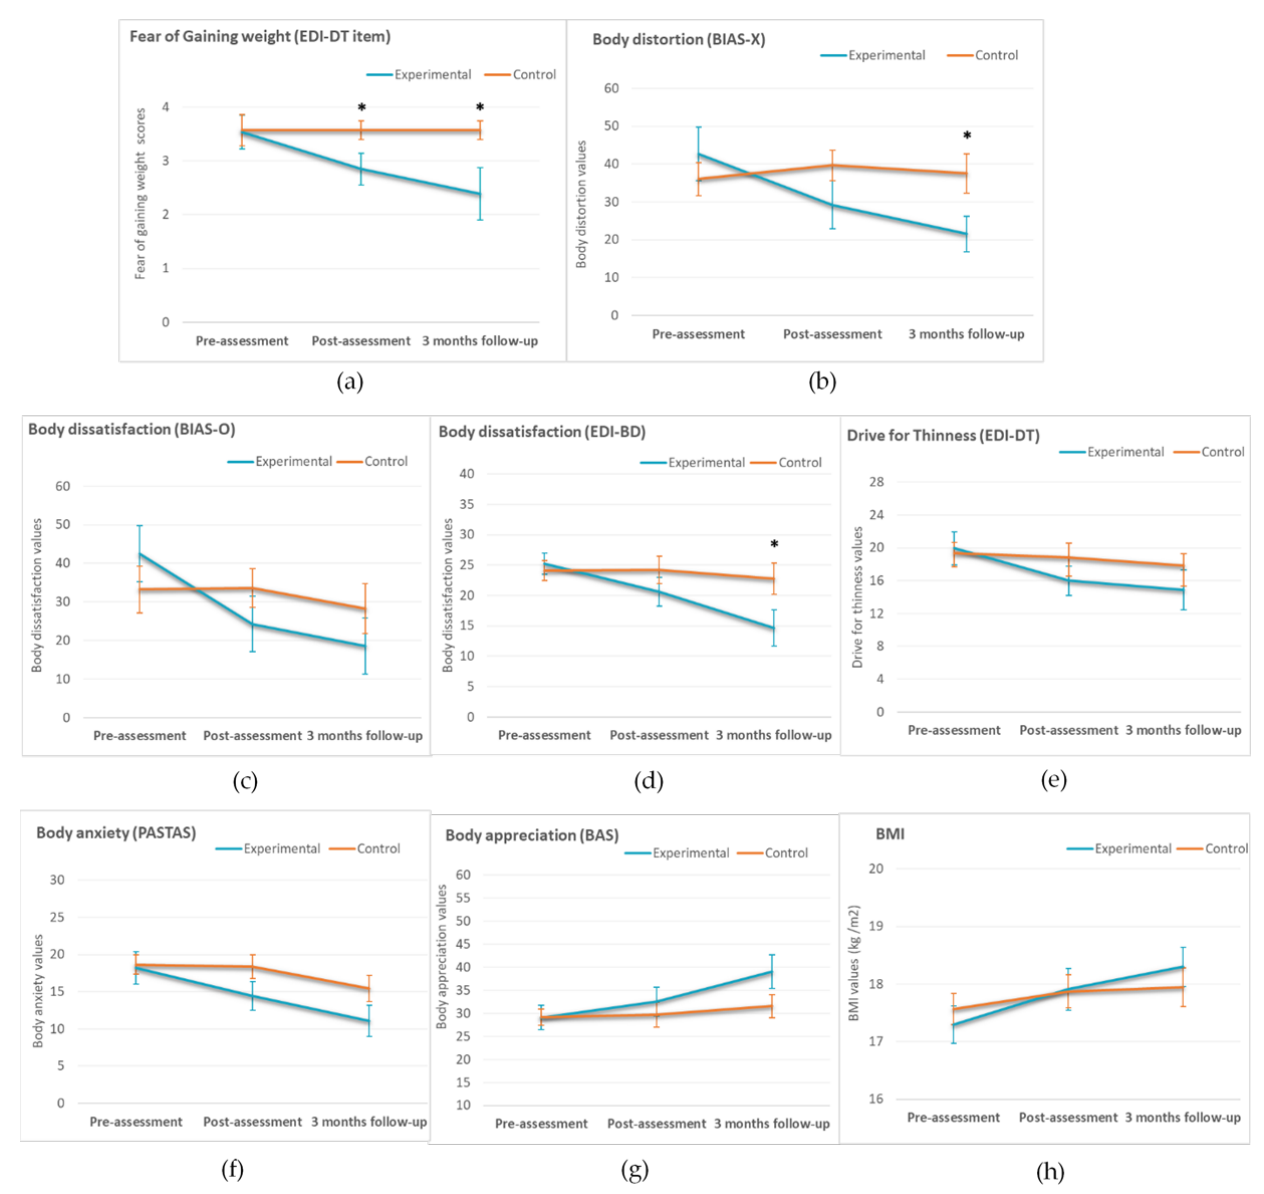
Figure 4. Means of the experimental and control groups in the three assessment conditions (pre-assessment, post-assessment, three months follow-up) in Fear of Gaining Weight ( a ), body distortion ( b ), body dissatisfaction as measured by the EDI-3 ( c ) and the BIAS-BD ( d ), Drive for thinness ( e ), body anxiety ( f ) body appreciation ( g ) and Body mass index ( h ) Complete fixation Time (3d) and Number of Fixations (3e). Error bars represent standard errors of the mean. Note: BMI = Body mass index. * p values < 0.05.